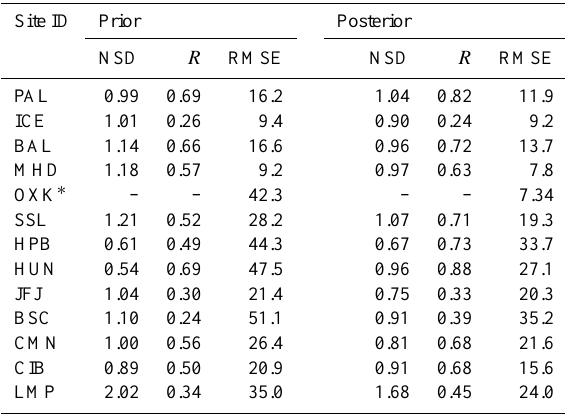
Table 6. Statistics of the simulated versus observed CH 4 mixing ratios from test